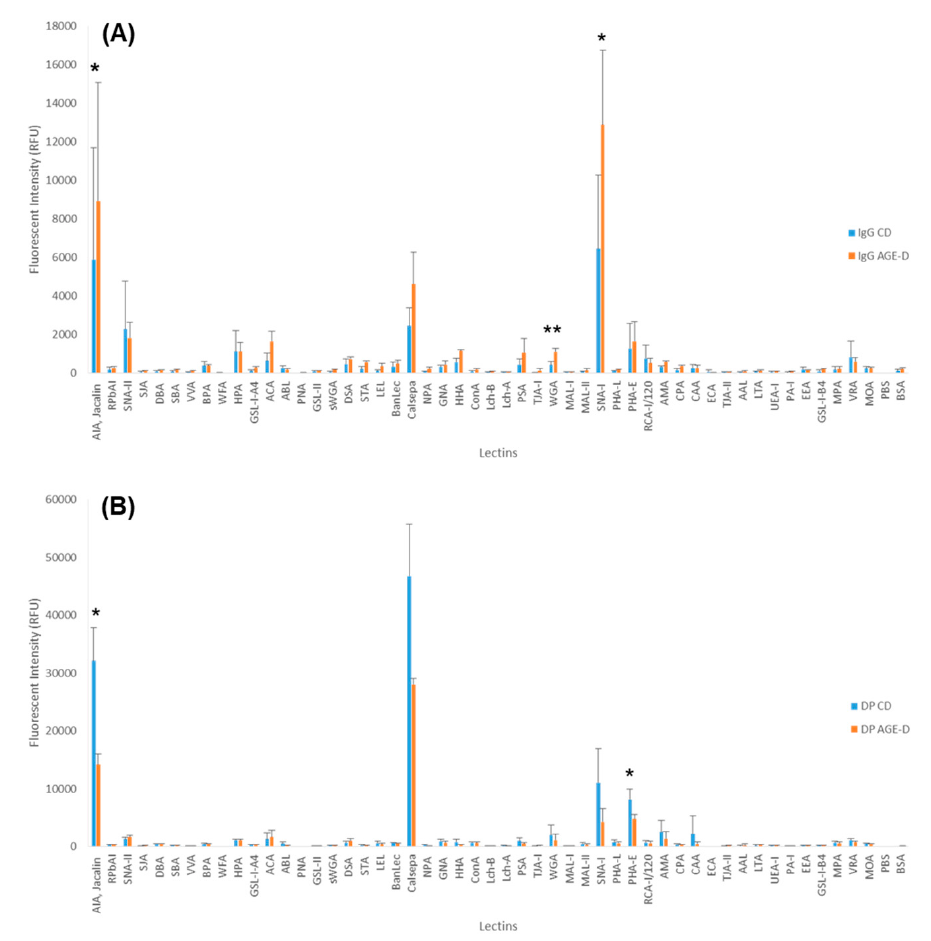
Figure 4. Glycosylation profiles of ( A ) immunoglobulin fractions, control diet (IgG CD) and control diet enriched in AGEs (IgG AGE-D) and ( B ) plasma glycoproteins depleted from IgG fractions, control diet (DP CD) and control diet enriched in AGEs (DP AGE-D). Bars represent the average binding intensity of fluorescently labelled samples from three technical replicate experiments and error bars represent +/ − standard deviation. Statistical significance: ** p < 0.01, * p < 0.05 vs. CD, determined by two-tailed, paired Student’s t-test.